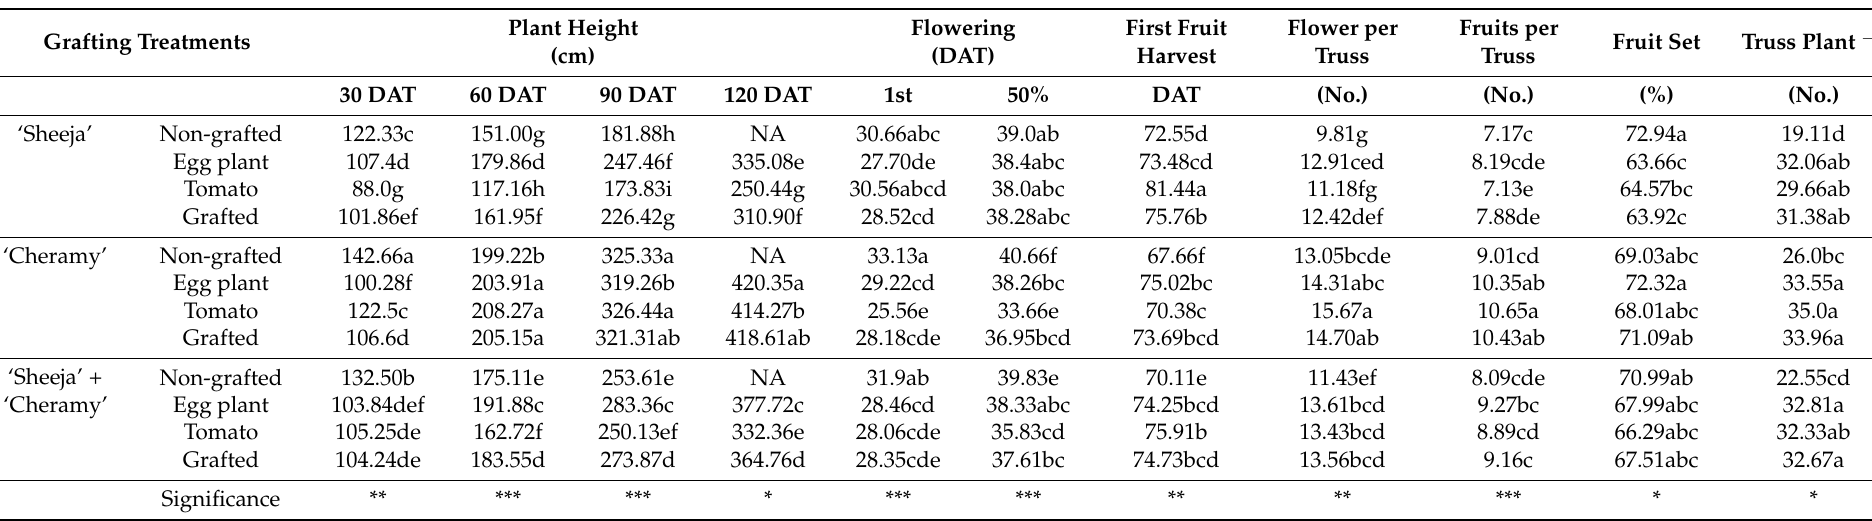
Table 4. Mean values of different plant parameters of different graft combinations of cherry